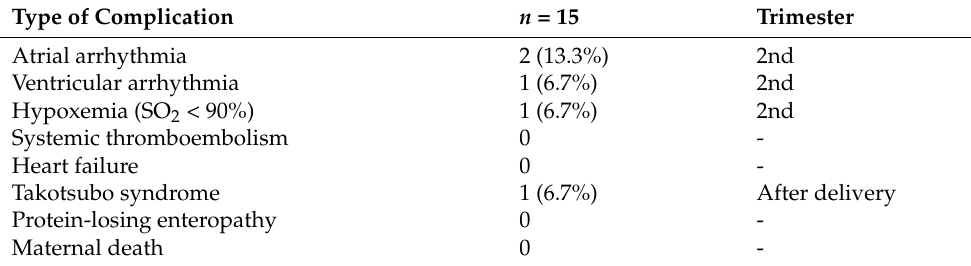
Table 4. Maternal cardiovascular complications during pregnancy and after